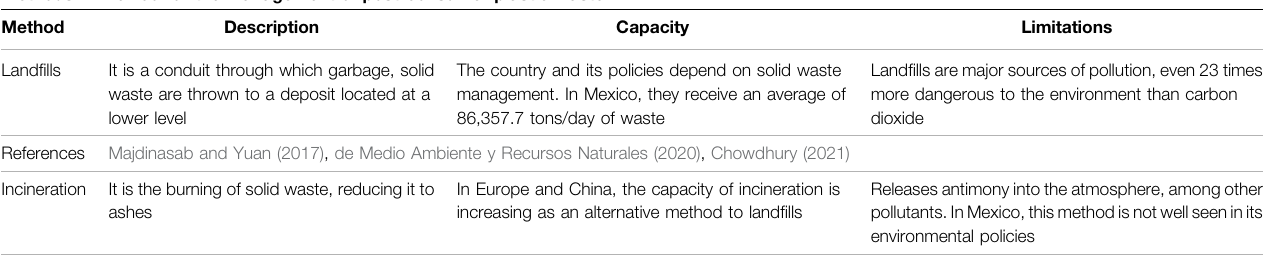
TABLE 2 | Urban solid waste management in